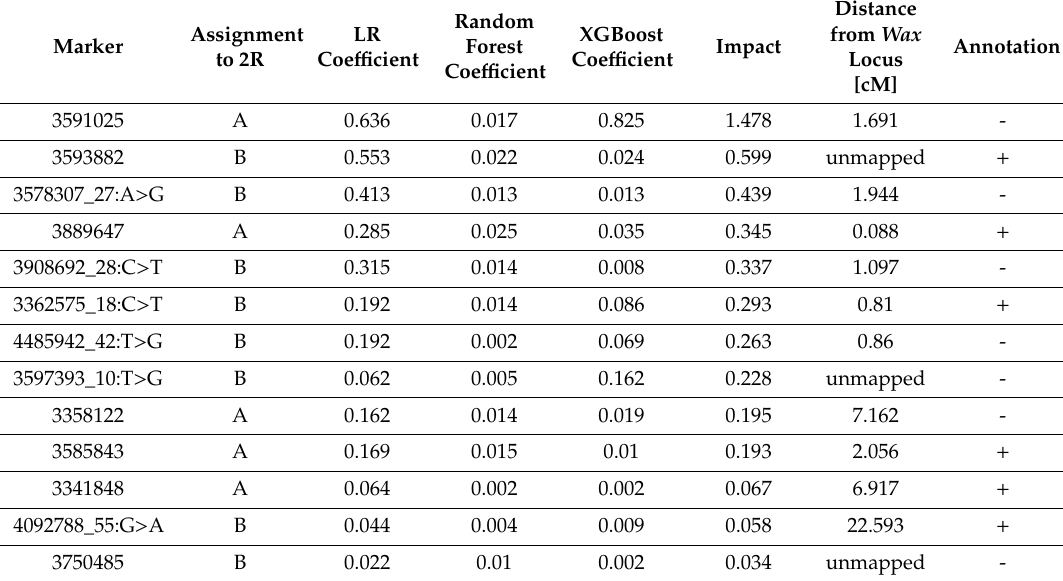
Table 3. DArTseqs indicated by three machine learning (ML) algorithms as important for distinguishing between waxy and waxless plants. Coe ffi cient values are draw out directly from models (in the case of logistic regression (LR) absolute values of coe ffi cients were used). Impact value is the sum of coe ffi